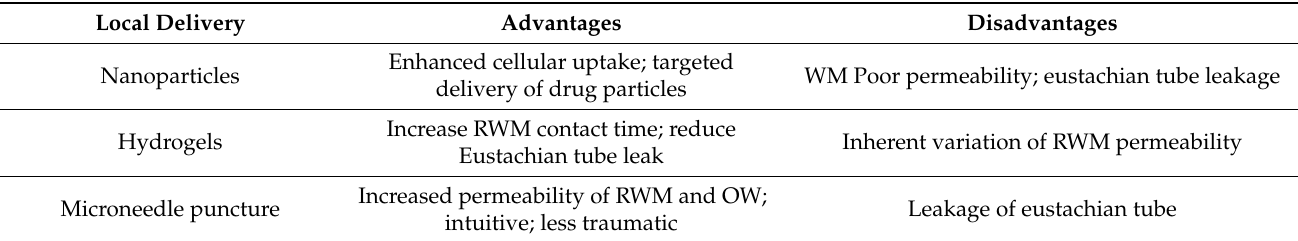
Table 2. Advantages and disadvantages of local